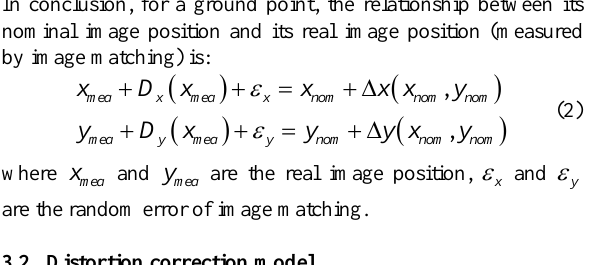
have continuity. Thus, the three-order B-spline function that has six inner nodes is used to fit the geometric distortion curves of the WFV images. One of the fitting results is illustrated in figure